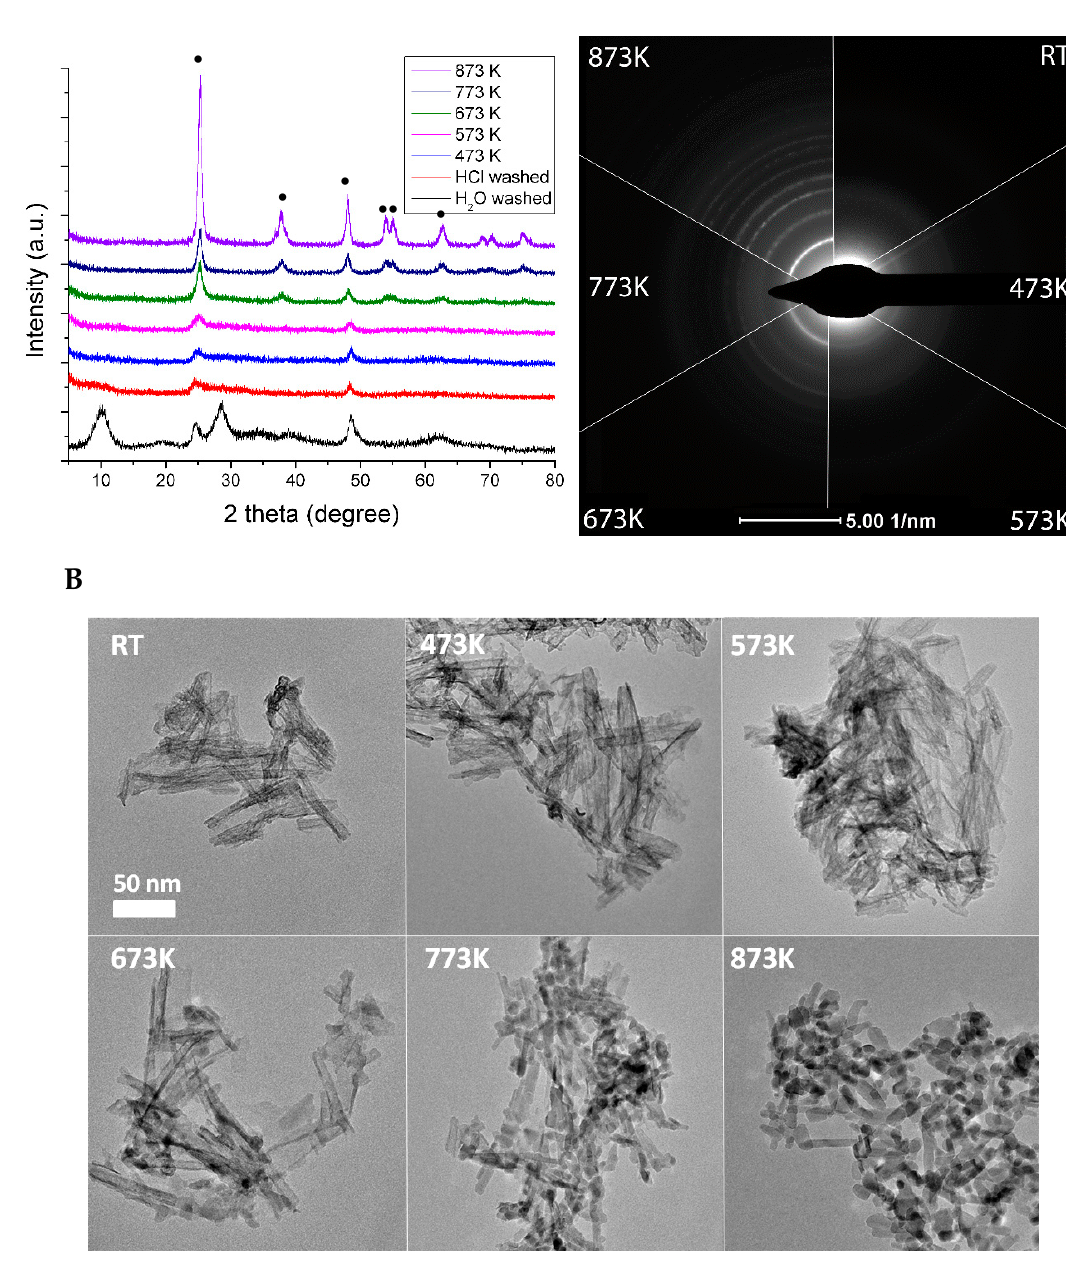
Figure 2. ( A ) XRD of “H-form” TiONT as a function of temperature. The bottom curve shows the XRD profile of H 2 O washed TiONT. • denotes anatase reflection. ( B ) TEM images of TiONT treated at different temperatures. Reproduced from Ref. [70].